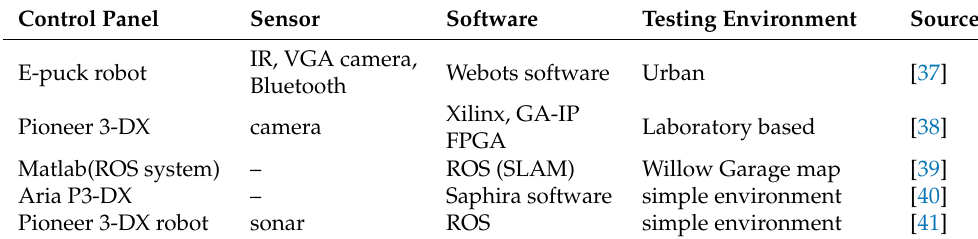
Table 1. Robotic parameters mentioned in different